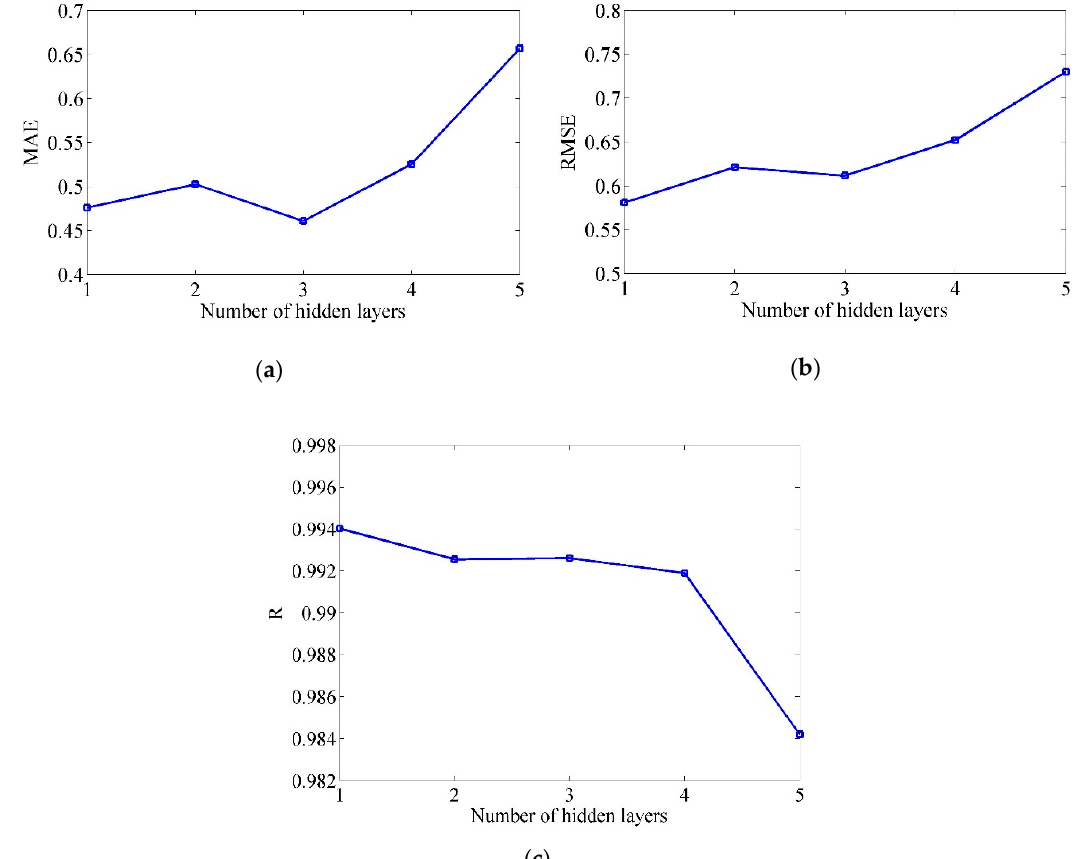
Figure 5. Evaluation indexes of models with different hidden layers: ( a ) MAE varies with the number of hidden layers; ( b ) RMSE varies with the number of hidden layers and ( c ) R varies with the number of hidden layers.